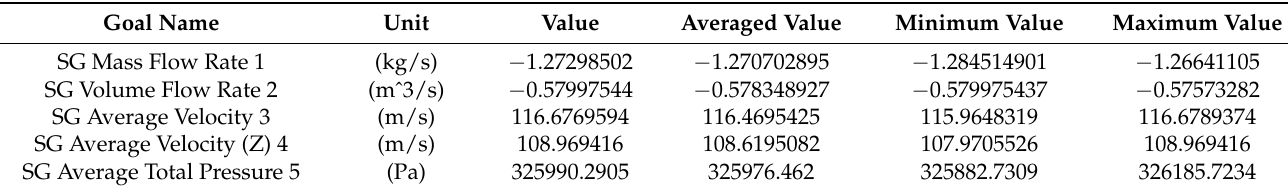
Table 4. Numerical results of mass and volume flow rate for the compressor outflow (Figure 11).